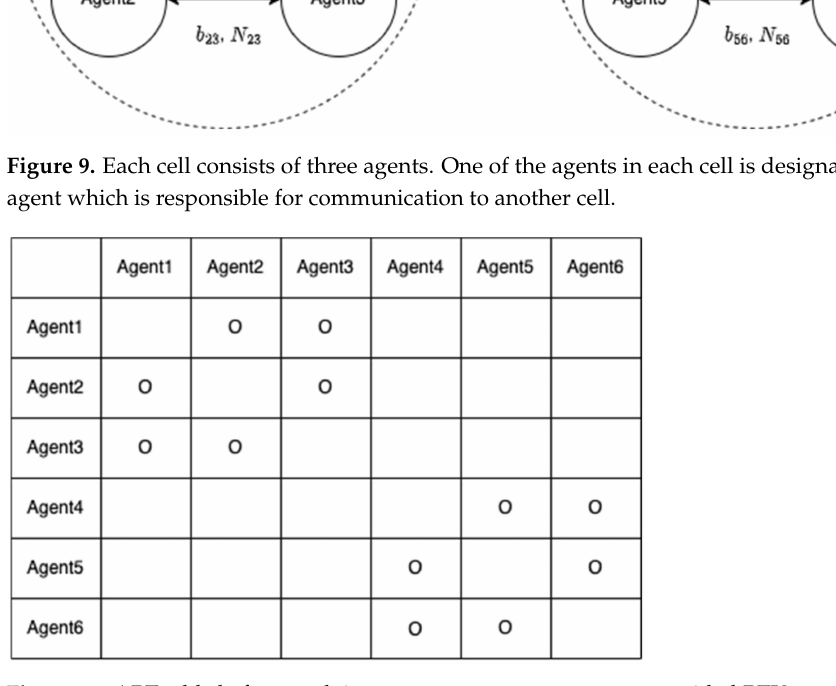
Figure 10. ART table before applying a one-to-one or antenna array-aided RTK across the two